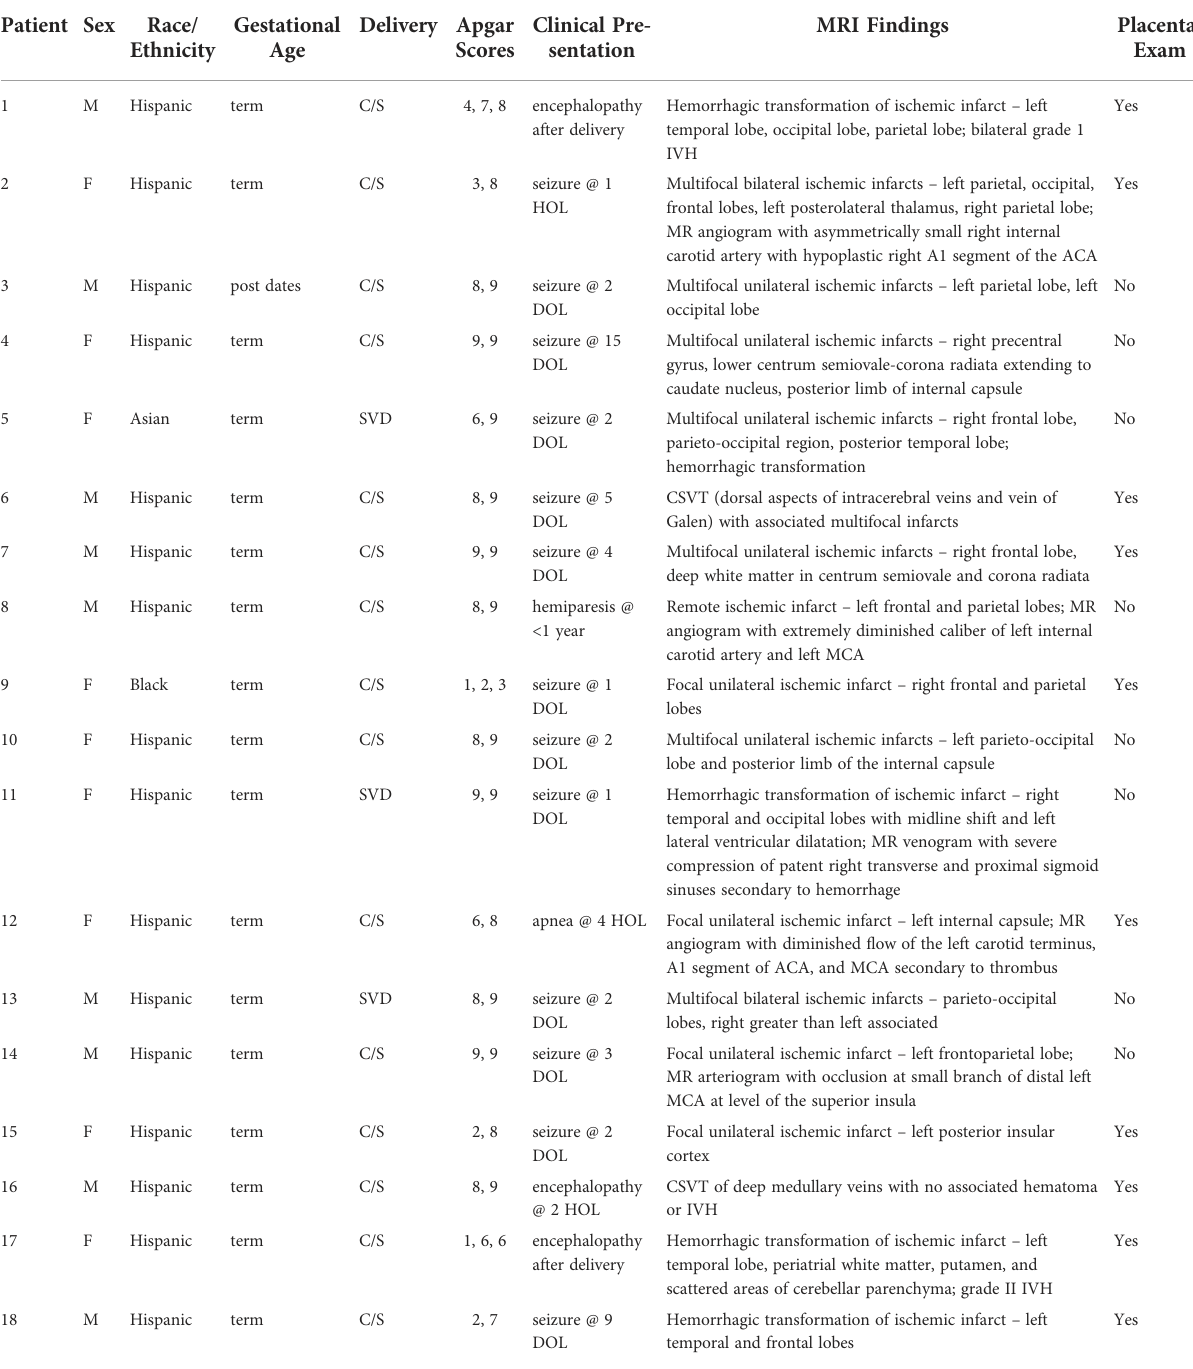
TABLE 2 Detailed clinical information . Patient